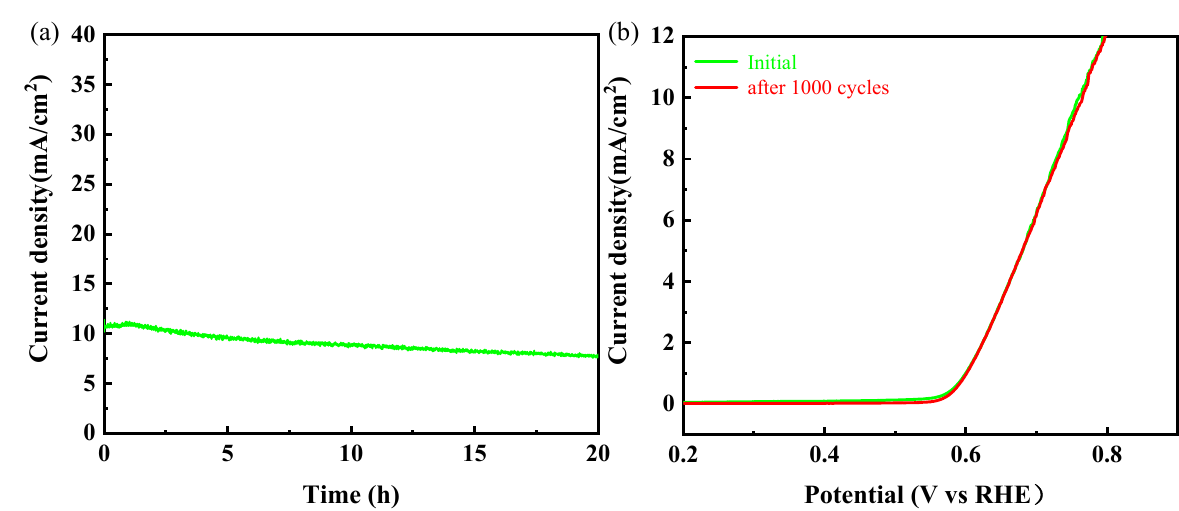
Figure 7. ( a ) i ~ t curve of CoP/FeP 4 @CNT with the current density of 10 mA cm − 2 in 1 M KOH solution at 1.533 V. ( b ) LSV curves of CoP/FeP 4 @CNT before and after 1000 cycles.